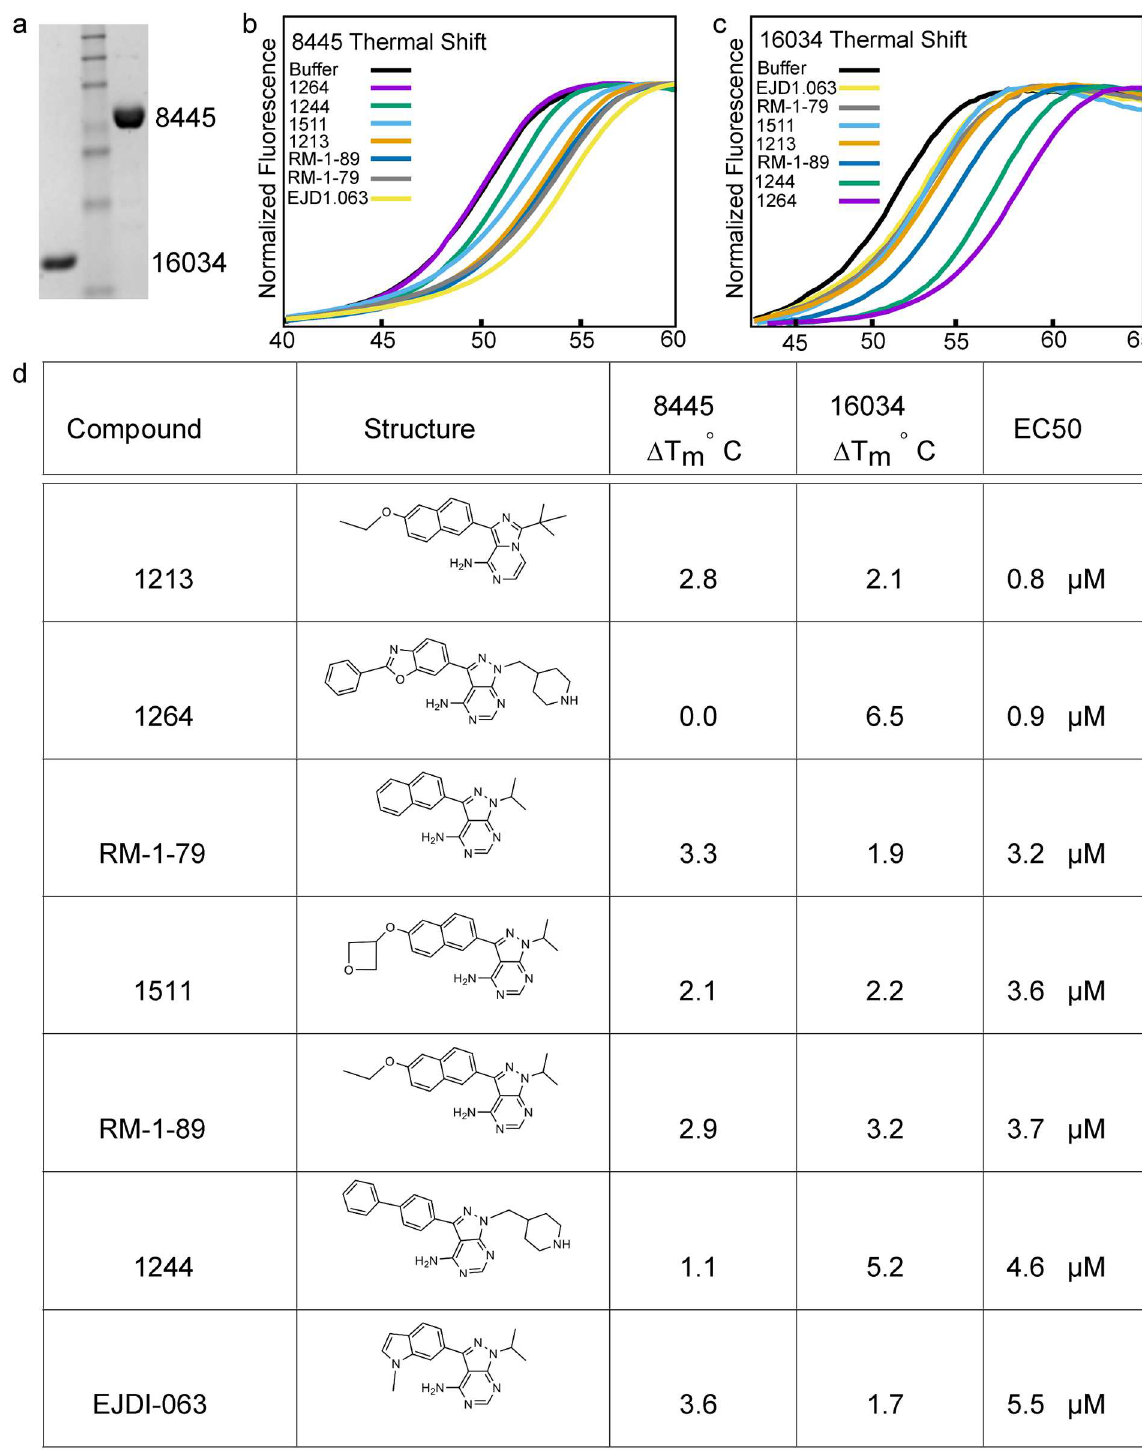
Fig 6. Thermal shift assaysidentify bumped kinase inhibitors that bind to purified proteins. Kinases Gl50803_8445 and Gl50803_16034 were purified from E . coli . (a) SDS-PAGE was used to estimate protein purity. Gl50803_8445 was 91% pure and Gl50803_16034 was 98% pure. Note that minor impuritiesare not expected to affect Δ Tm determination. (b, c) Melting curves for the BKIS showingthe largest Δ Tm are shown for Gl50803_8445 (b) and Gl50803_16034 (c). (d) The name, chemical structure, Δ Tm, and EC 50 value obtained for 7 BKIs prioritizedfor phenotypiccharacterization of anti-growth activity (Also see S3 Fig).